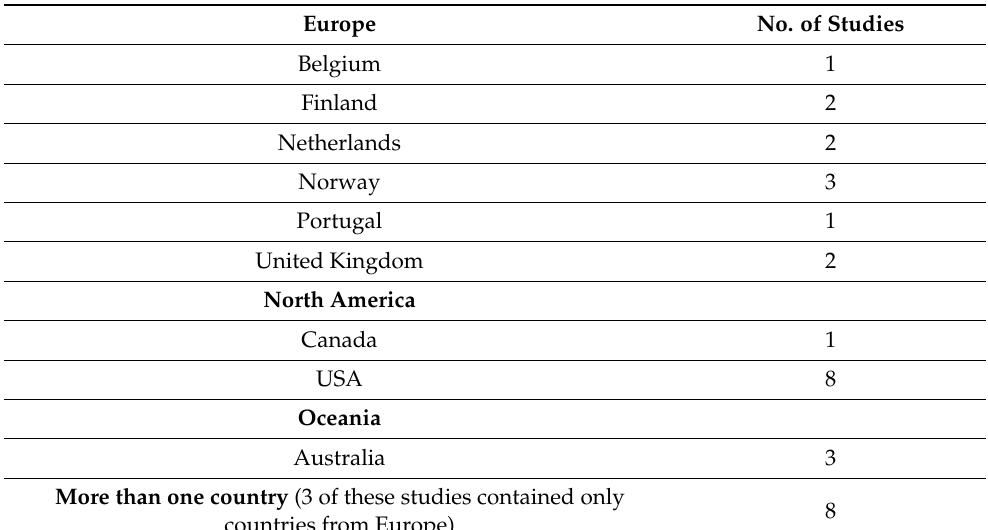
Table 2. Descriptive information about the included studies’ origins (continent and country).